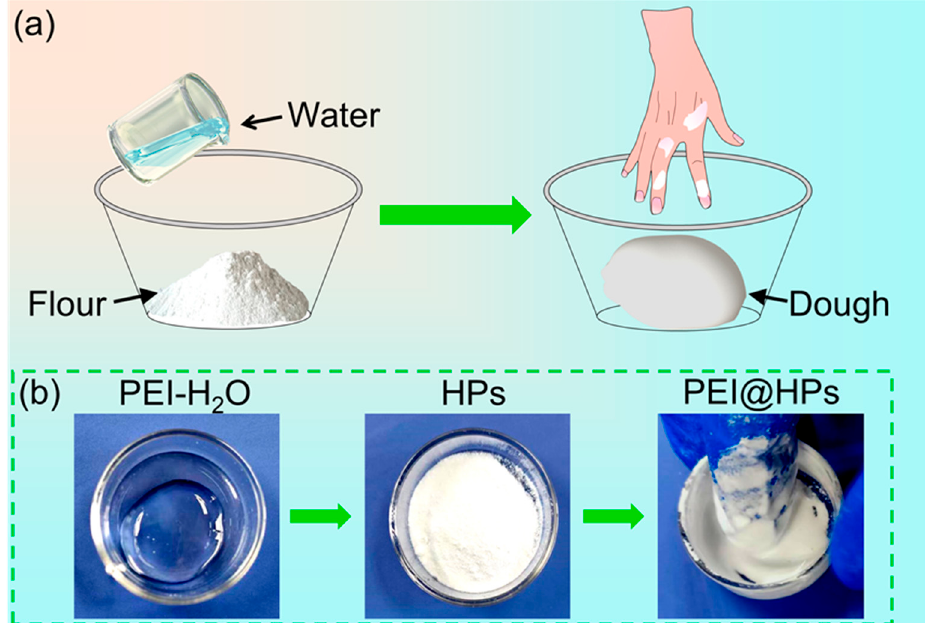
Figure 1. ( a ) Scheme of kneading dough with fl our and water. ( b ) Photos of kneading HPs (e.g., KH570-modi fi ed SiO 2 ) with PEI solution (Mw ~70,000, 50 wt%) until smooth and sticky dough-like gel was